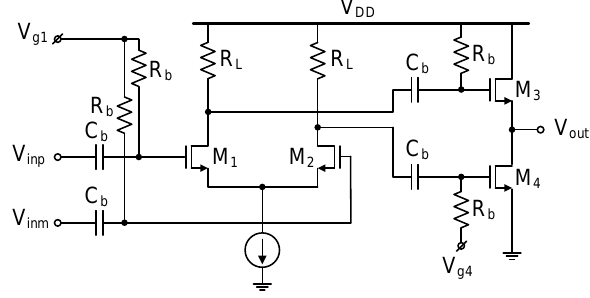
Figure 9. Baseband amplifier (BBA).